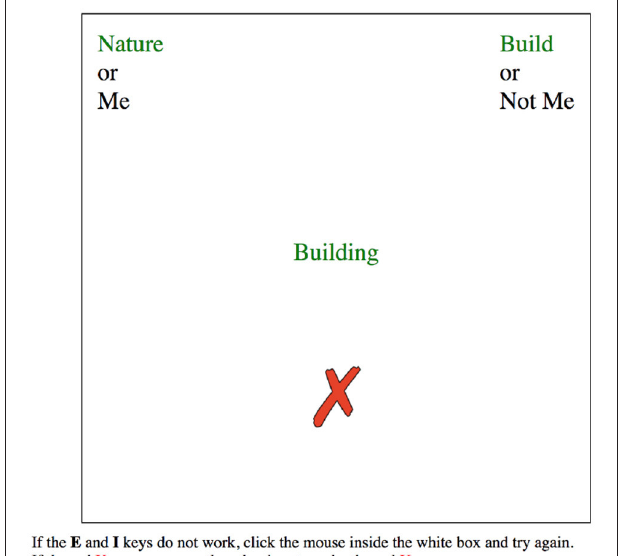
FIGURE 3 | The Implicit Association Test (IAT) screen with congruent categories pairing and inaccurate response.